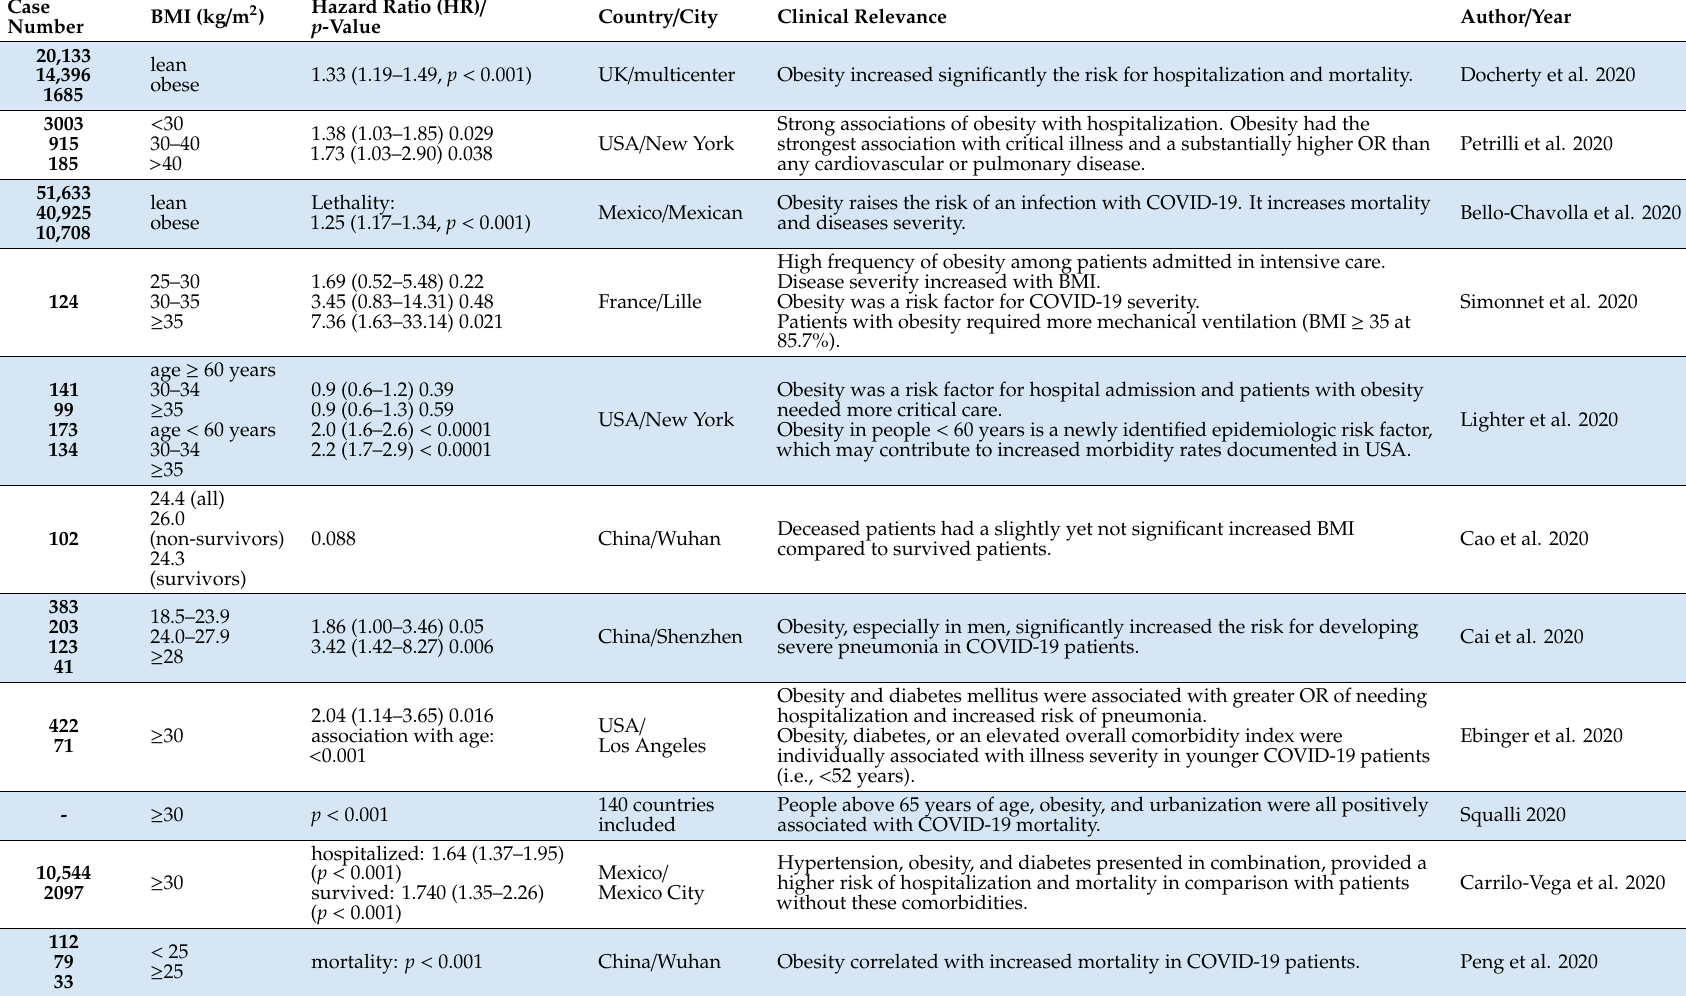
Table 1. Clinical reports of COVID-19 patients with